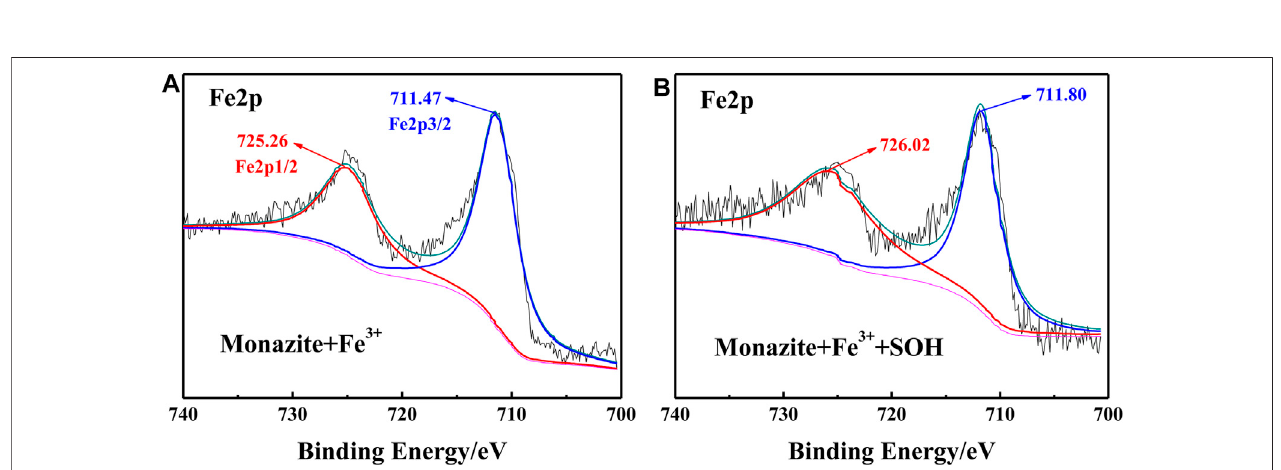
FIGURE 9 | Fe2p XPS spectrum on (A) monazite surface treated with Fe 3+ and (B) monazite surface treated with Fe 3+ and SOH, respectively.